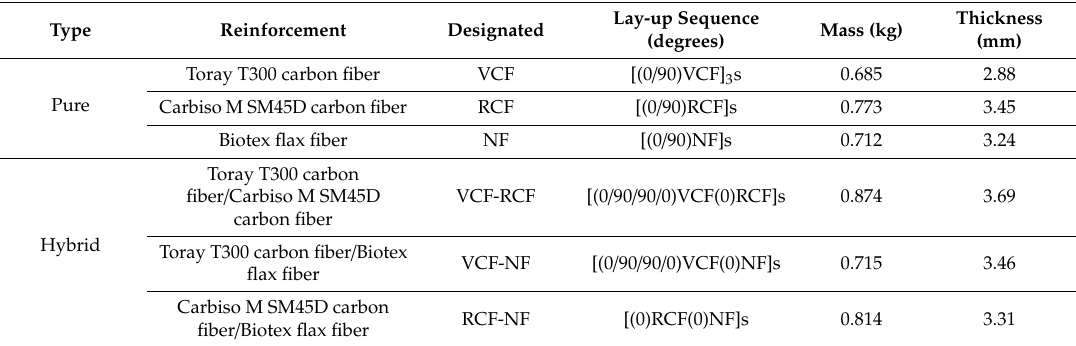
Figure 2. Diagram of double bag vacuum infusion (DBVI) set up. When the inlet and outlet ports were opened, resin was drawn through the inlet tube and permeated the dry fabric. The infusion valves were closed once resin began to collect in the catch pot. Vacuum pressure was maintained on the secondary bag throughout curing. As the IN2 resin system optimally cures at room temperature, panels were left undisturbed for 24 h before being released from the caul plate. In addition, all panels were post-cured in a convection oven at 80 °C for 4 h, following the profile suggested by the resin datasheet.